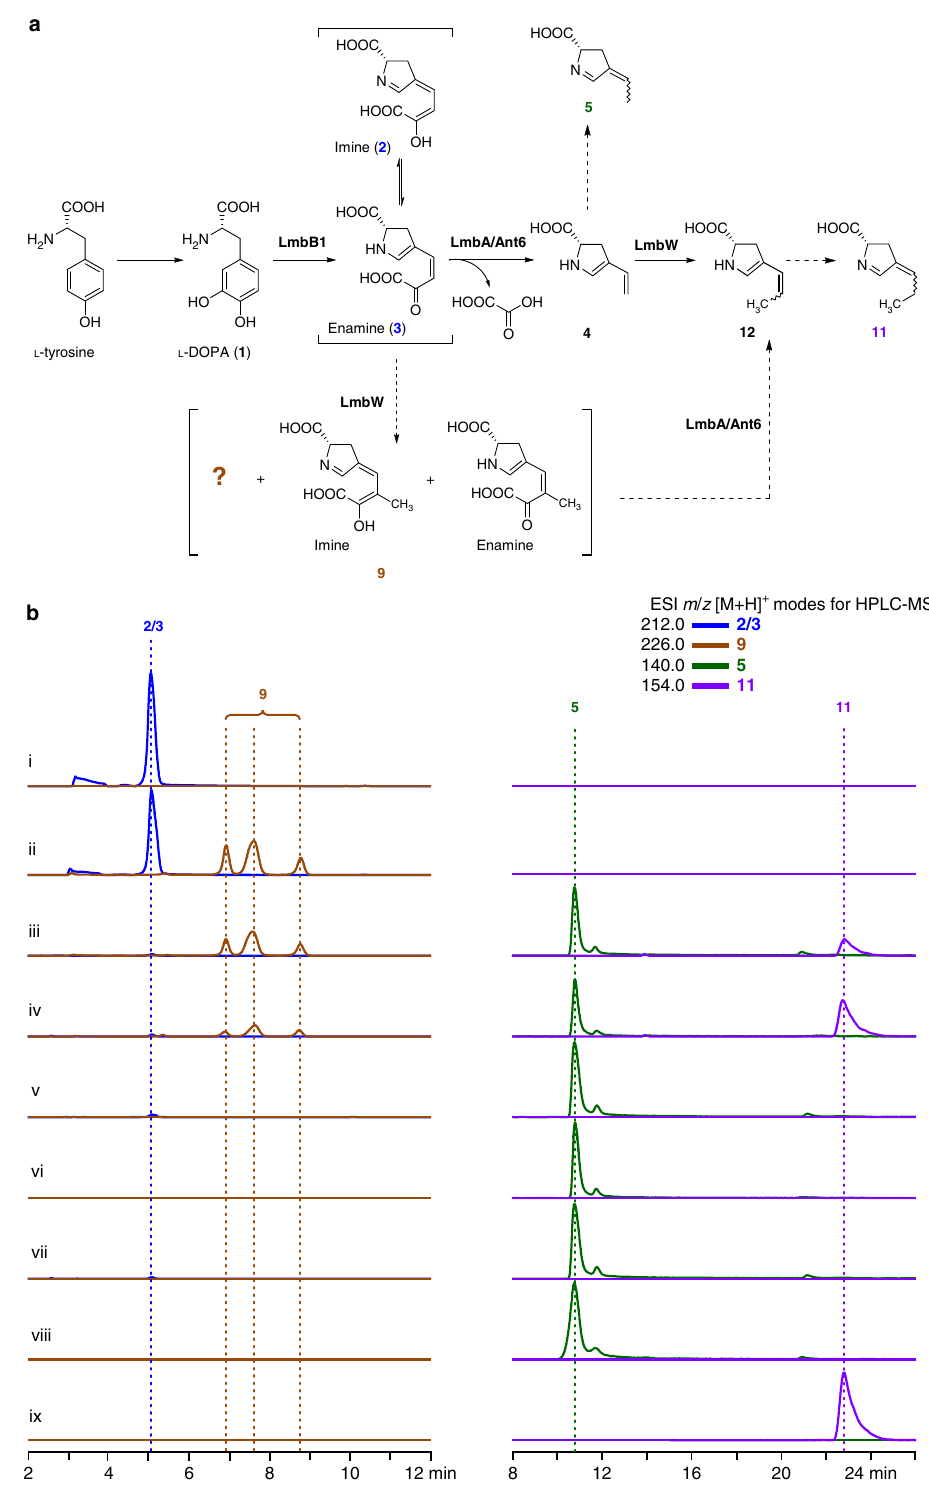
Fig. 1 Timing of C – C bond cleavage and C -methylation in the formation of ALDP residues. a A common pathway for ALDP formation in the biosynthesis of lincomycin A and anthramycin. Main and shunt reactions are indicated by solid and dashed arrows, respectively. b Assays of the Ntn-hydrolase activity of Ant6 and the C -methyltransferase activity of LmbW by HPLC-MS. Substrate 2 / 3 was prepared in situ through LmbB1-mediated transformation of L